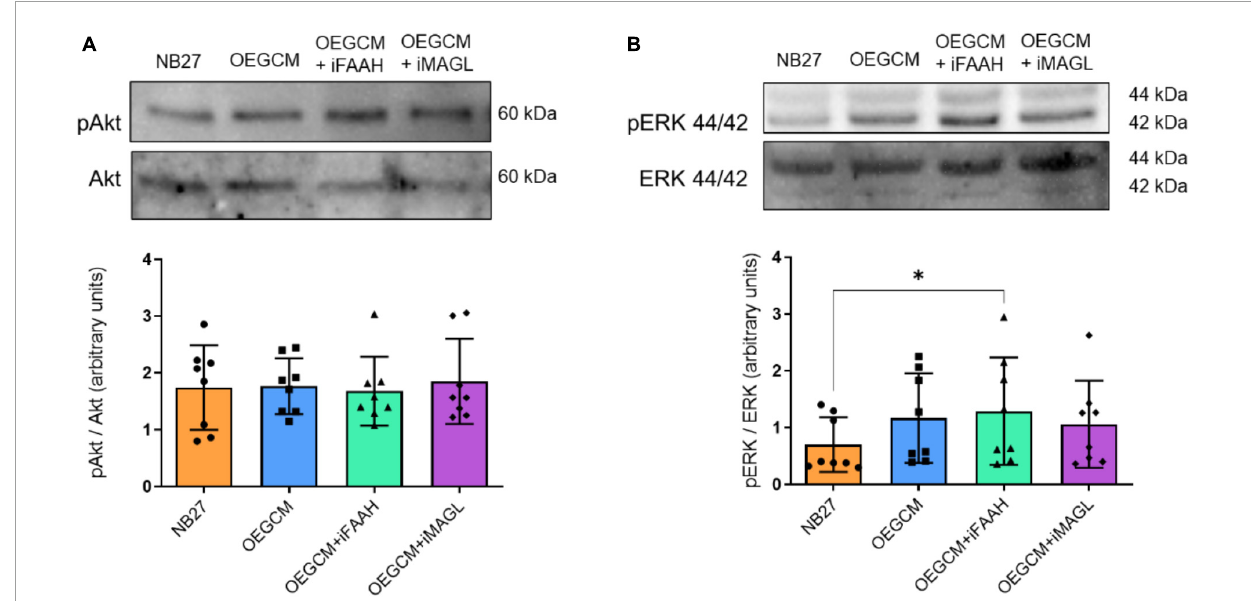
FIGURE10 The phosphorylation of proteins associated with cellular signaling pathways in hippocampal cell cultures is not affected by the OEGCM from cells treated with FAAH or MAGL inhibitors. In panel (A) , representative western blotting of pAkt and Akt (60 kDa) and quantification of pAkt in relation to total Akt. Data is presented as mean ± SD, statistical analysis was performed using Friedman and Dunn’s as post hoc test. N = 8 for all experimental conditions, p > 0.9999 for all comparisons. In panel (B) , representative western blotting of pERK 44/42 and ERK 44/42 (44 kDa/42 kDa) and quantification of pERK 44/42 in relation with ERK 44/42. Data is presented as mean ± SD, statistical analysis was performed using Friedman and Dunn’s as post hoc test. N = 8 for all experimental conditions, p = 0.4882 for NB27 vs. OEGCM, p = 0.0402 for NB27 vs. OEGCM + iFAAH, p = 0.4882 for NB27 vs. OEGCM + iMAGL, p > 0.9999 for OEGCM vs. OEGCM + iFAAH, p > 0.9999 for OEGCM vs. OEGCM + iMAGL. * p <